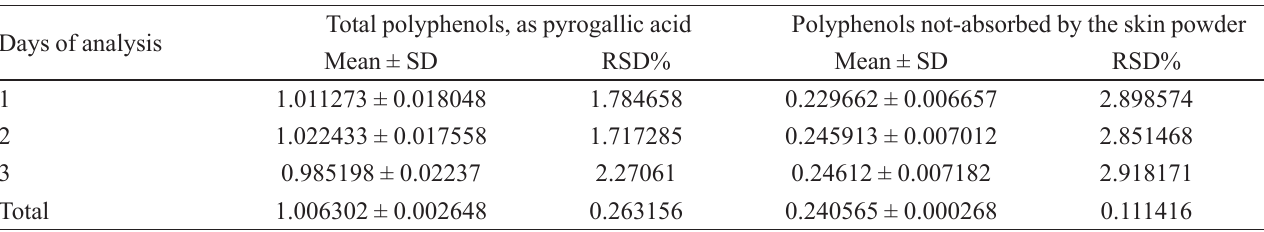
TaBLe II - Precision, as RSD%, for the total polyphenols, as pyrogallic acid equivalents, and for the polyphenols not-absorbed by the skin powder Days of analysis